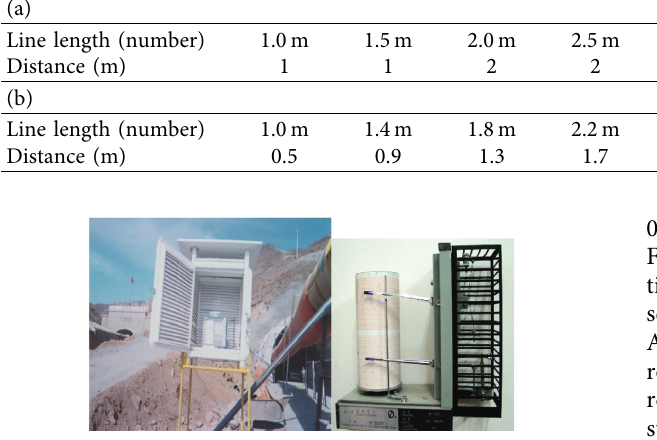
Figure 6: ZJI-2B intelligent